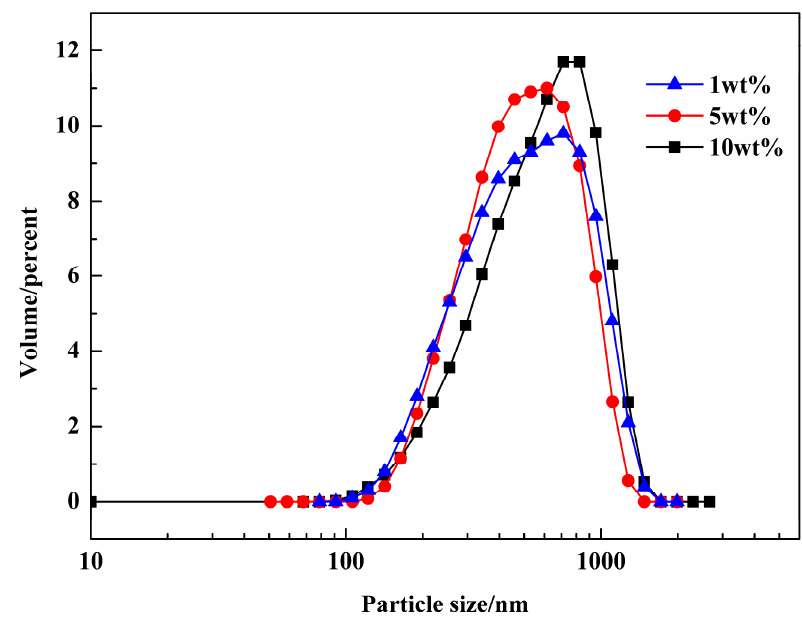
Figure 9. Particle size distributions of PR 146 products obtained from macroemulsions containing different dosages of emulsifier.